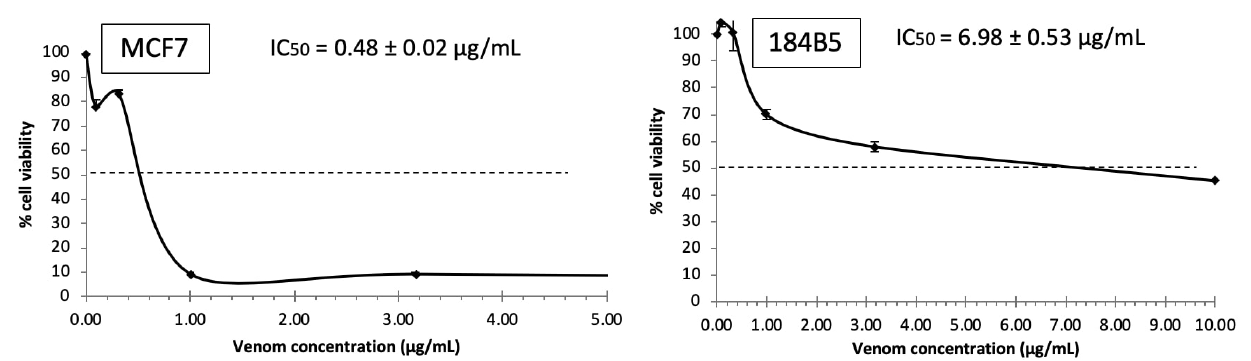
Figure 1. Dose-dependent growth inhibitory effect of Trimeresurus purpureomaculatus (MTP) venom in human breast cell lines. Median inhibition concentrations (IC ) were determined from the dose-response curve. Values were presented as means ± S.E.M. ( n = 3). MCF7: human breast cancer cell line, 184B5: human 50 breast normal cell